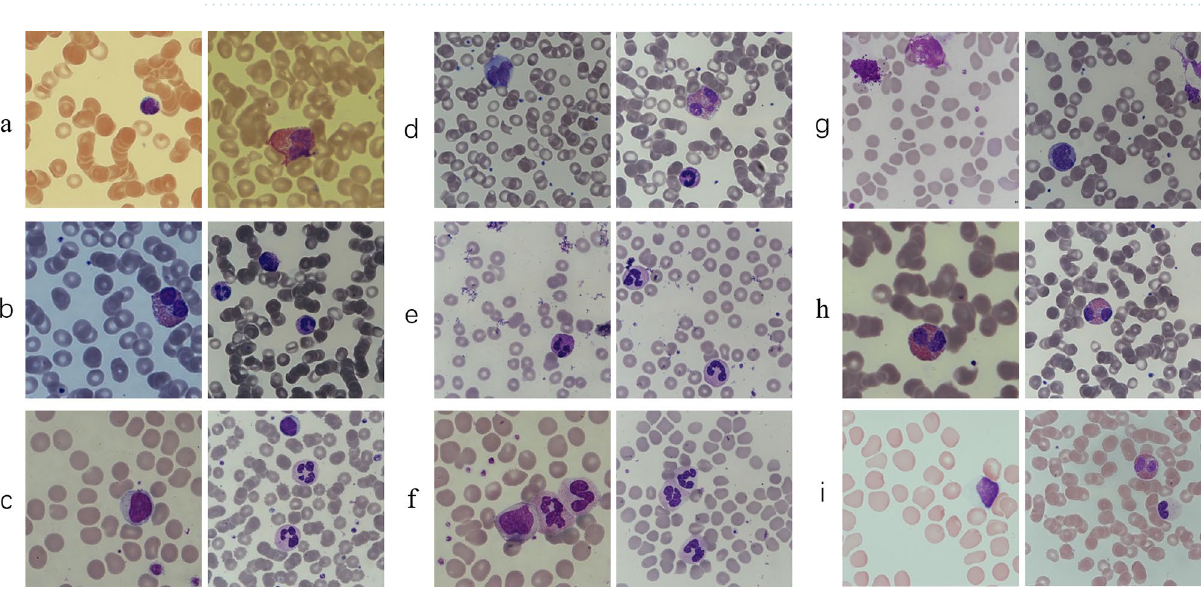
Figure 3. Some exemplar samples are affected by the interference factors. ( a ) Colour casts on blood cell smear images; ( b ) low illuminative intensity of blood cell smear images; ( c ) giant platelets; ( d ) incorrect imaging focal length of cell images; ( e ) images containing dyes or other impurities; ( f ) overlapping leukocytes; ( g ) degenerated leukocytes; ( h ) excessively high phosphate buffer solution (pH > 6.8); ( i ) excessively low phosphate buffer solution (pH <